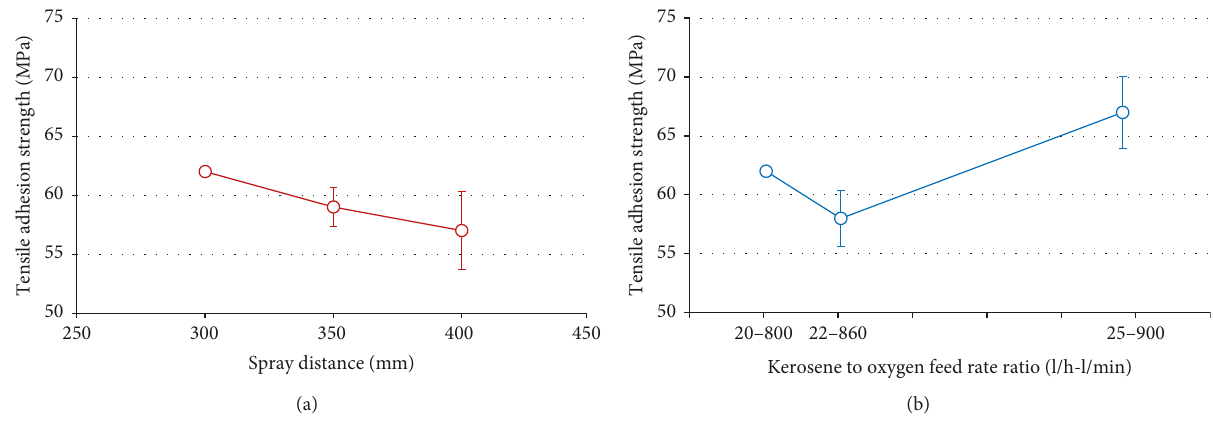
Figure 2: Effect of (a) spray distance and (b) kerosene to oxygen feed rate ratio on coating tensile adhesion strength. 4.55.05.56.06.57.0